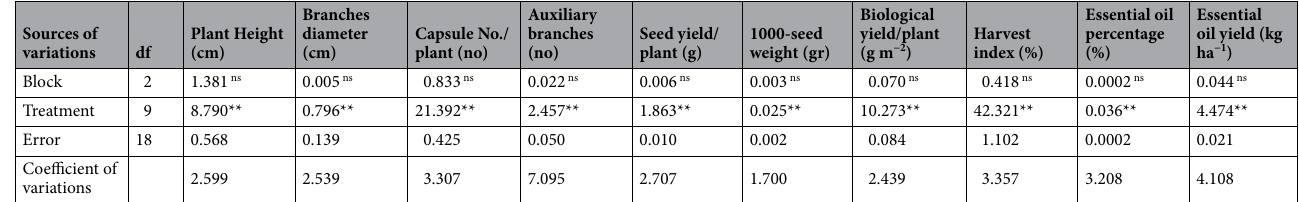
Table 1. The results of analysis of variance for the effect treatment on morphological traits. Ns non- significance; *significance at the p ≤ 0.05 level; **significance at the p ≤ 0.01